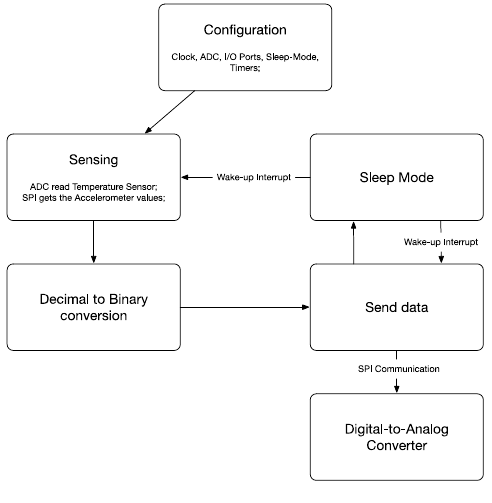
Figure 5. Code diagram.